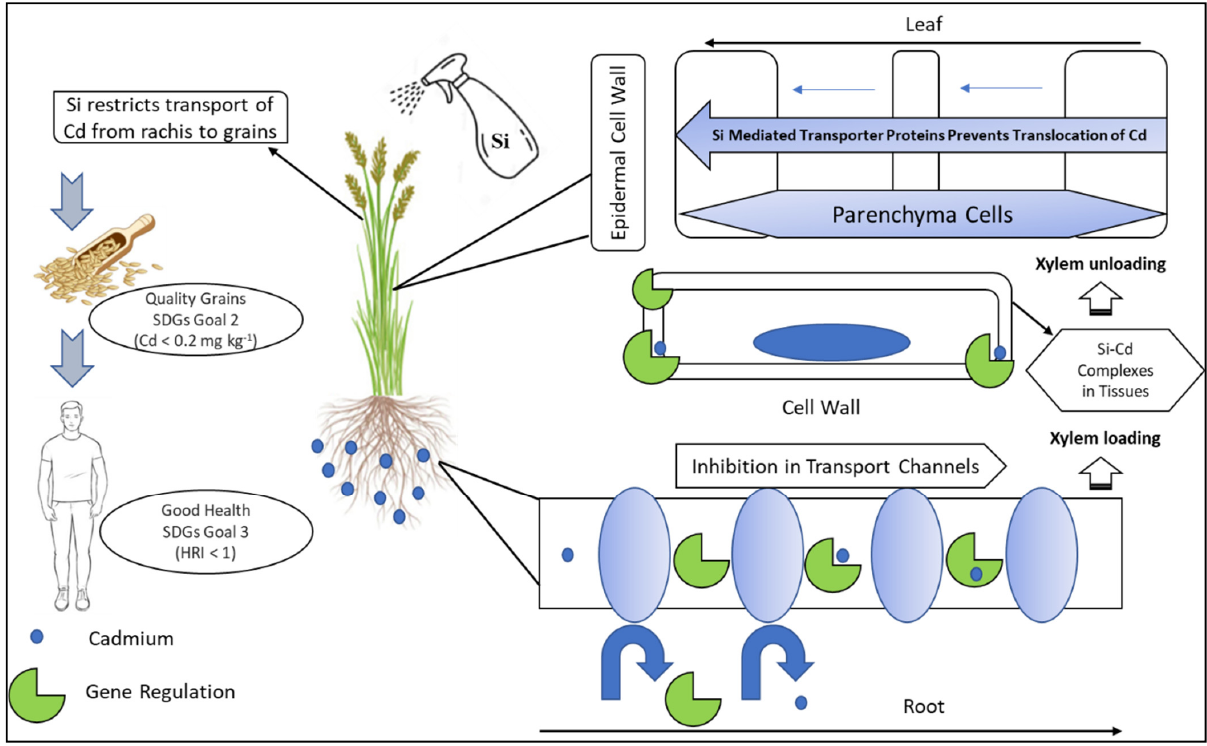
Figure 2. A schematic diagram of uptake, transport, and accumulation of Si in rice plant. Soil applied Si is absorbed by the roots to the root exodermis by the influx transporter genes and afterward released to the apoplast by the efflux transporter genes. However, exogeneous application of Si is translocated into the xylem and transported via the transpiration pull to the shoots. In the leaves, Si is localized in the xylem parenchyma cells of leaf and unloaded by transporter genes. That ultimately results in restriction of Cd entry from rachis to grains producing quality rice for good health.